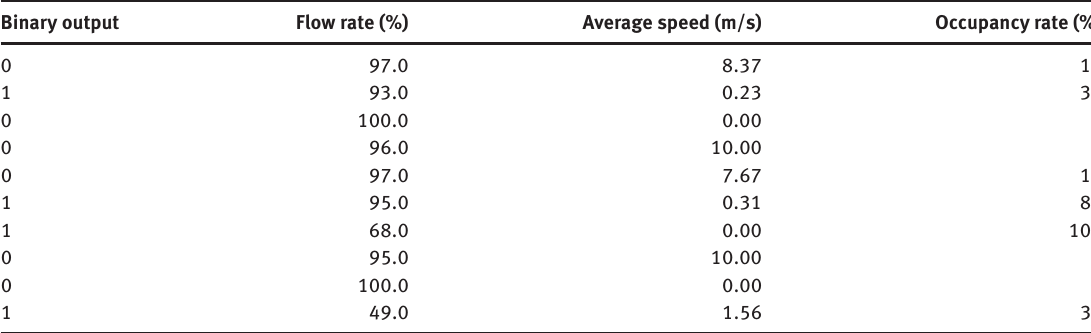
Table 3: Training Data Extracted from Target Domain Network with One